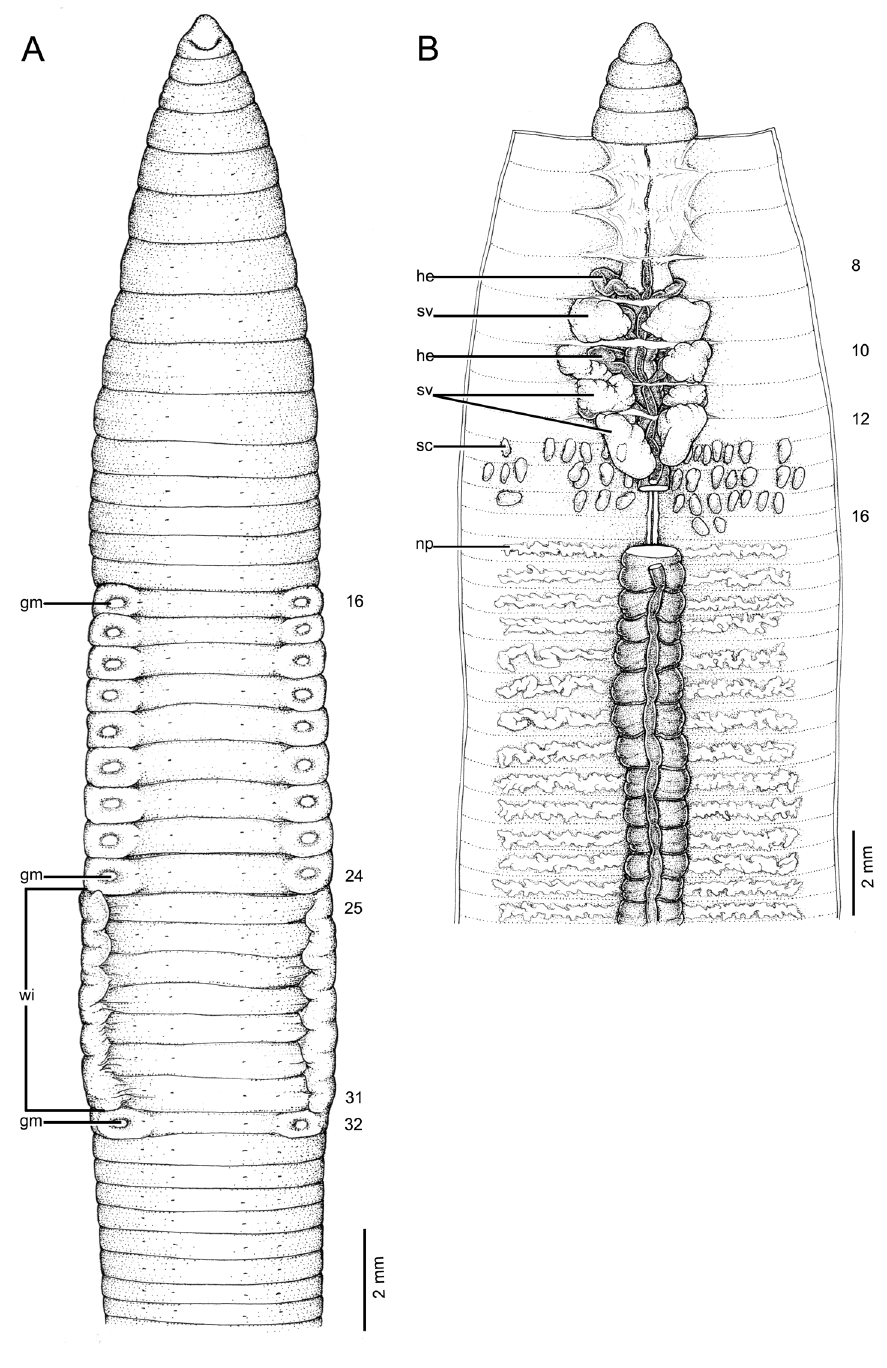
Figure 9. Morphology of holotype (CUMZ 3422) of Glyphidrilus sekongensis sp. n. A external ventral view, annular clitellum in XVI–XXXVII B internal dorsal